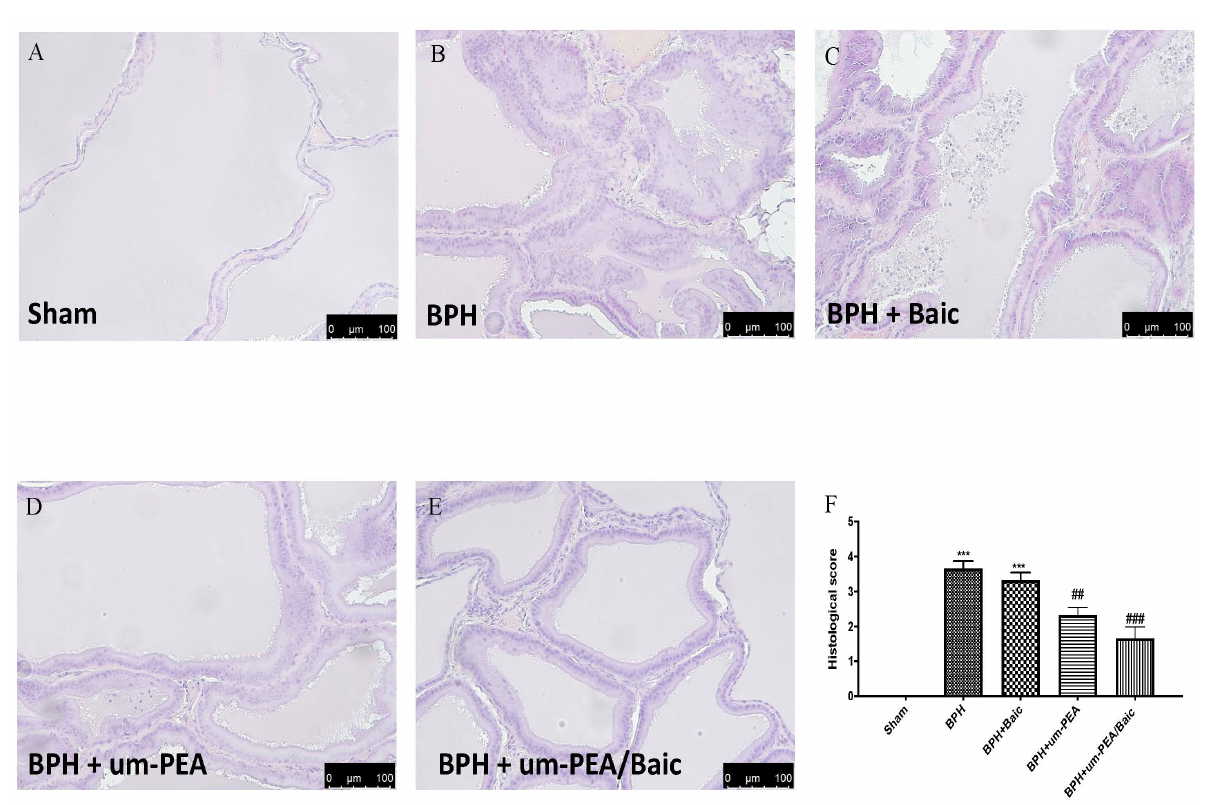
Figure 3. Effect of um-PEA/Baic on prostate morphology. Histological evaluation of the prostate: sham ( A ); BPH ( B ); BPH + Baic ( C ); BPH + um-PEA ( D ); BPH + um-PEA/Baic ( E ); histological score ( F ). Images are indicative of at least 3 independent experiments. Values shown are means ± SEM of six animals in each group. A 20X magnification is shown (100- µ m scale bar). *** p < 0.001 vs. sham; ## p < 0.01 vs. BPH group; ### p < 0.001 vs. BPH group.